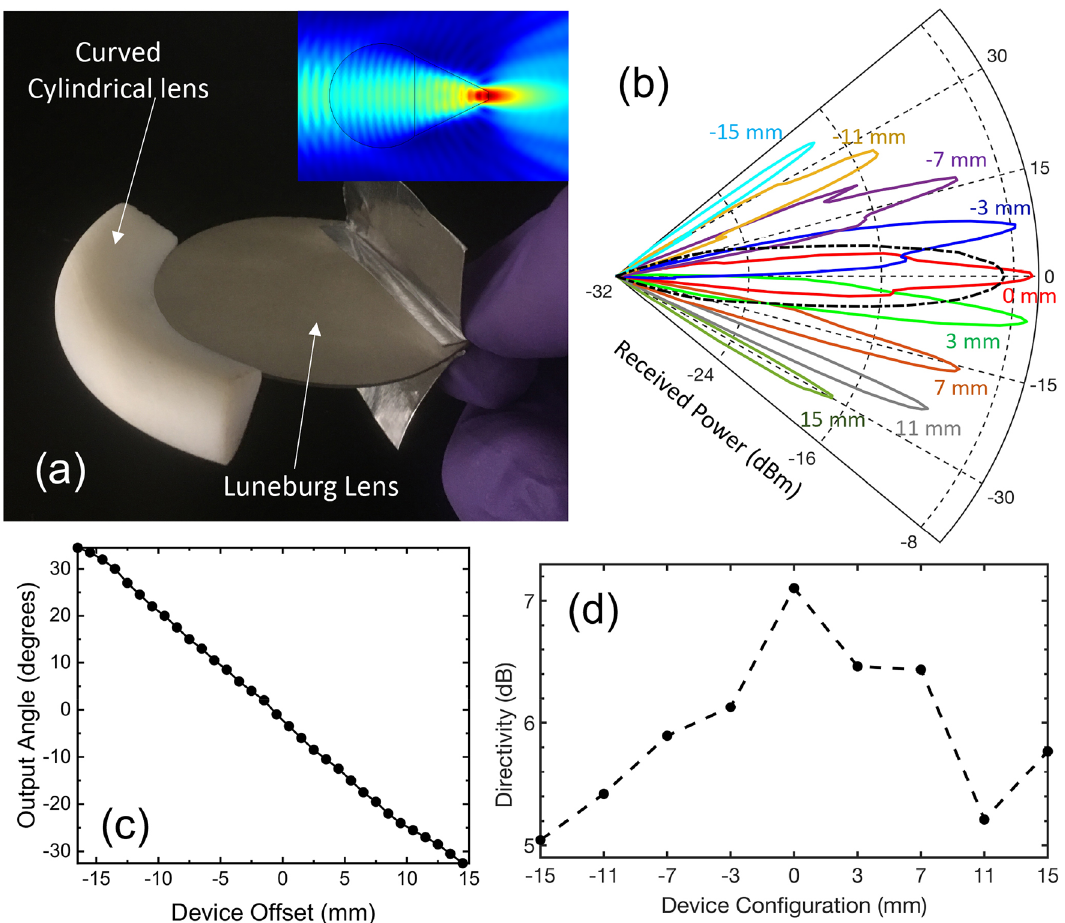
Figure 4. ( a ) Photograph of the device with curved cylindrical lens attached. (inset: 2D numerical simulation of beam focusing using the cylindrical lens). ( b ) Output beam profiles in a polar plot. ( c ) Measured output beam angle as a function of the device offset. ( d ) Directivity of the device extracted from our measurements shown in ( b ).